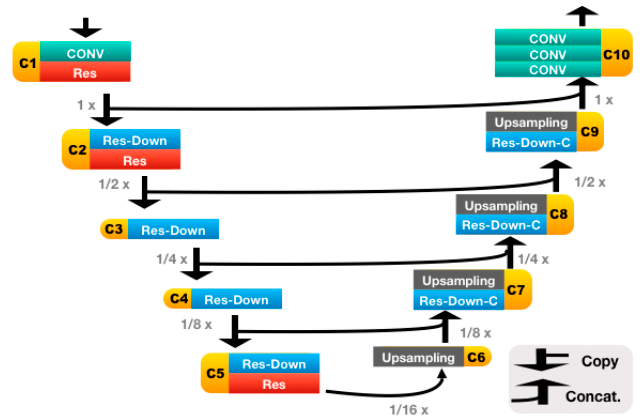
Figure 4. The ResUNet architecture. This network has 31 convolutional layers and is made of the following blocks: CONV, Res, Res-Down, Res-Down-C and Upsampling. The upsampling block performs bilinear upsampling and is non-learnable. The remaining four learnable blocks are illustrated in Figure 5.